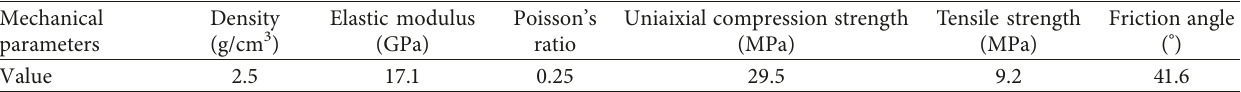
Figure 1: Experimental preparation and the indenter. Table 1: Main mechanical parameters of the rock samples.